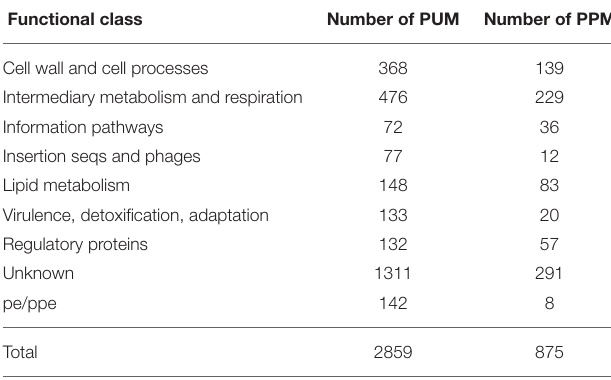
TABLE 5 | The distribution per functional class of 2859 proteins unique to MTB (PUM) and that of 875 with pseudogenes in MLP (PPM). Functional